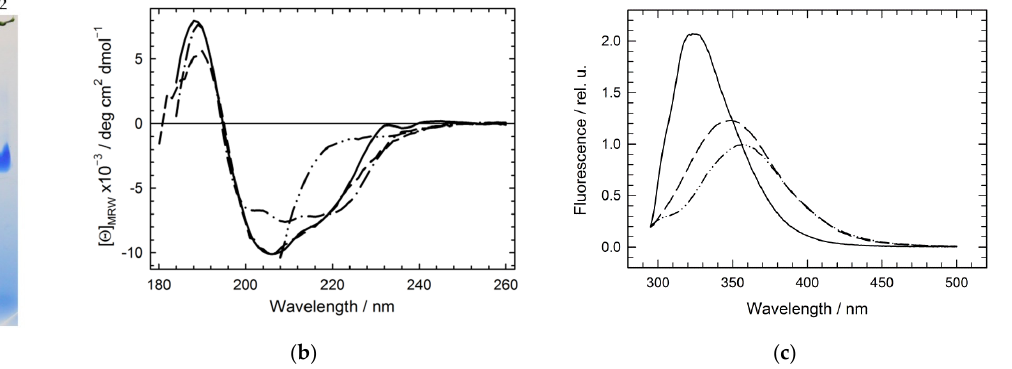
Figure 2. Structural properties of the hexameric Hfq Y55W and monomeric Hfq Y55W/D9A/V43R mutants: ( a ) Native polyacrylamide gel electrophoresis (PAGE) of the monomeric (track 1) and hexameric (track 2) forms; ( b ) Far-UV circular dichroism spectra for WT (dash-dot line), Y55W (solid line), Y55W/D9A/V43R (dashed line) Hfq variants, and any variant in the presence of 5 M GuHCl (dash-dot-dot line); ( c ) The fluorescence emission spectra for Hfq Y55W in three states (Equation (2)): the native hexameric (solid line, spectrum center of mass CM = 337 nm), the monomeric Y55W/D9A/V43R mutant(dashed line, CM = 355 nm), and unfolded monomeric (in the presence of 5 M GuHCl; dash-dot-dot line, CM = 360 nm); Protein concentration (monomer): 65 μ M; Buffer: 20 mM Tris-HCl, pH 8.5.